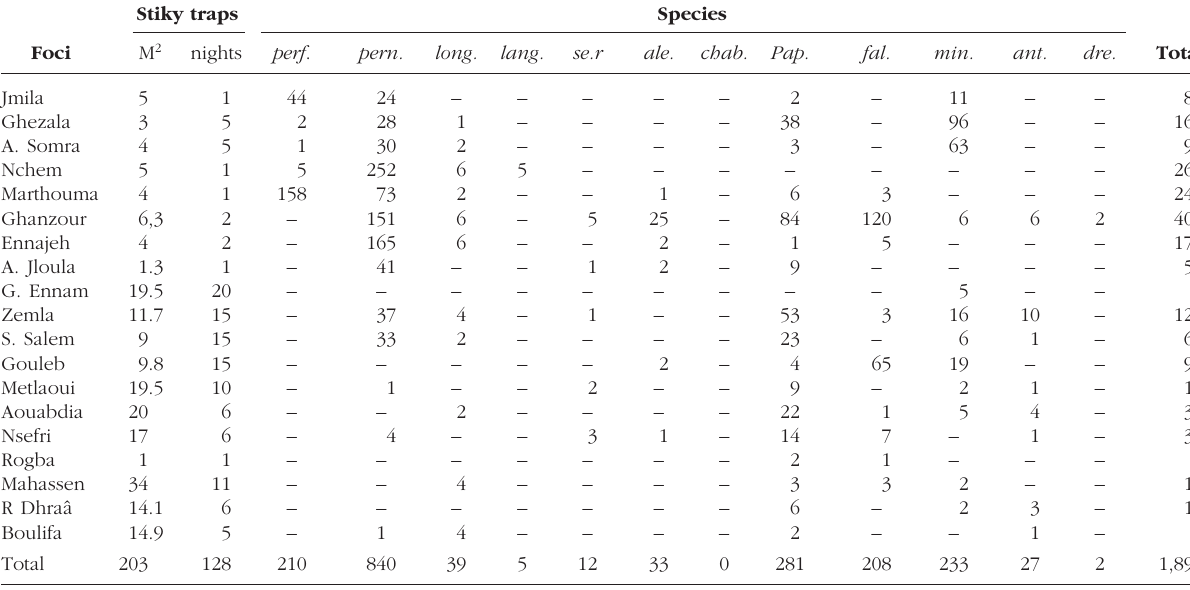
Stiky traps Species Foci M 2 nights perf . pern.